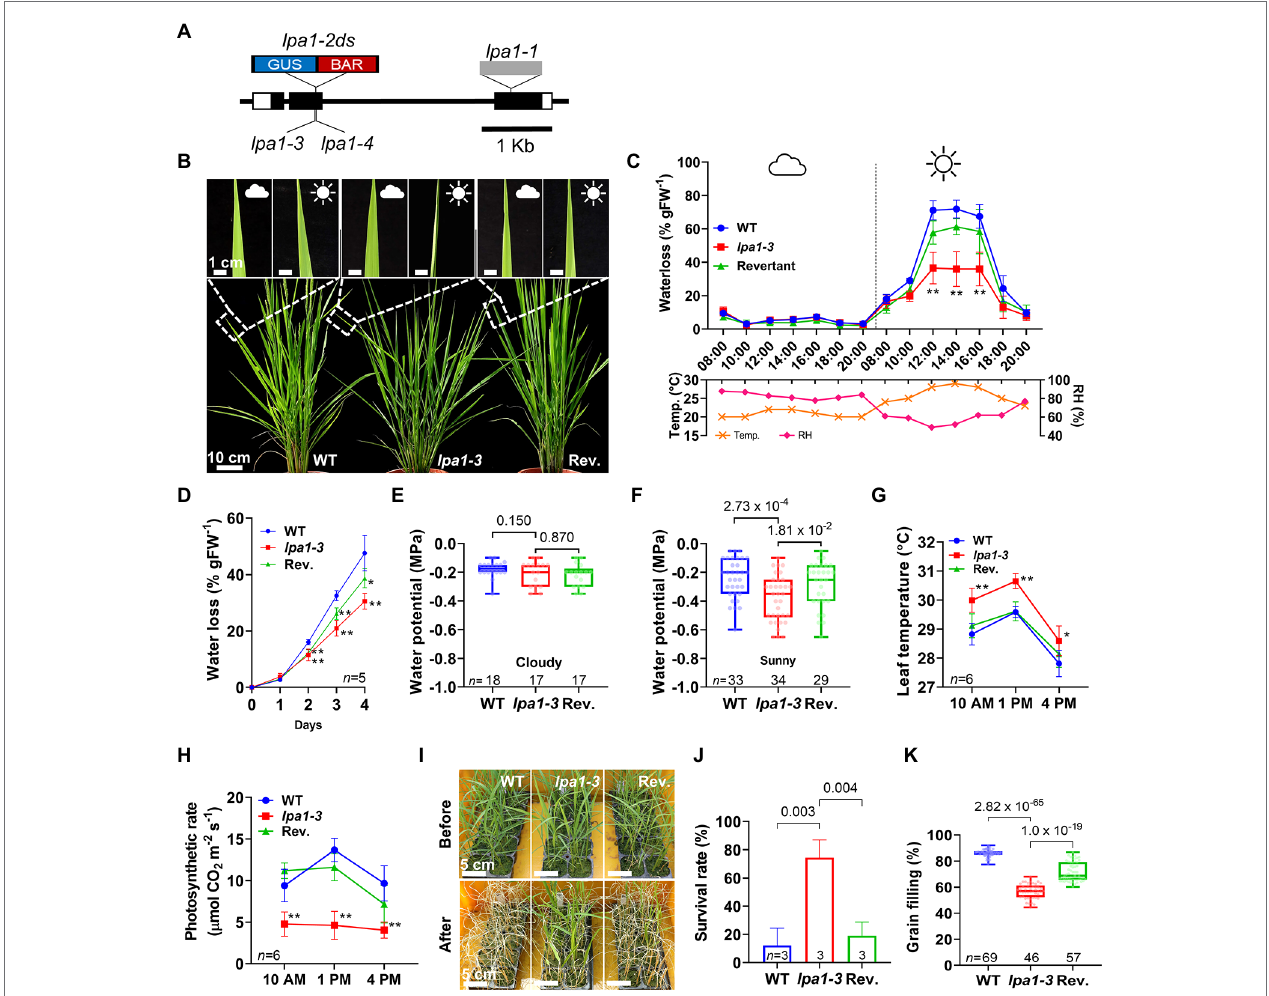
FIGURE 1 | Water use-related traits of lpa1 . (A) Genomic map of the locations of the lpa1 alleles. Blue:red box and grey box indicate Ds and a Ty1 -copia retrotransposon inserted in the exon (black box). GUS, β - glucuronidase; BAR, basta . (B) Representative field leaf phenotypes of wild type (WT), lpa1-3 , and the revertant (Rev.). Inserts show the same leaves on cloudy and sunny days. (C,D) Quantification and comparison of water loss using whole plants in the vegetative stage on a cloudy and a sunny day (C) , and using the aerial organs of seedlings from which the roots were removed (D) , Temp., temperature; RH, relative humidity. Measured from five replicates for (C) . (E–H) Comparison of water potential under cloudy day (E) and under sunny day (F) , and leaf temperature (G) and photosynthetic rates (H) of WT, lpa1- 3, and revertant at the three sequential time points (10 AM, 1 PM, 4 PM) on a sunny day. (I) Representative images of the three genotypes before and after subjected to drought stress. (J,K) Comparison of survival rates of the drought stress assay (J) and grain filling rate (K) of WT, lpa1-3 , and revertant. Weather symbols indicate the local weather on a whole day. Bar and line graphs display mean ± SD. Values of p denoted on the graph, two-tailed, two-sample t -test (* p < 0.05; ** p < 0.01). For each box plot, the lower and upper bounds of the box indicate the first (Q1) and third (Q3) quartiles, respectively, the center line indicates the median. n , number of